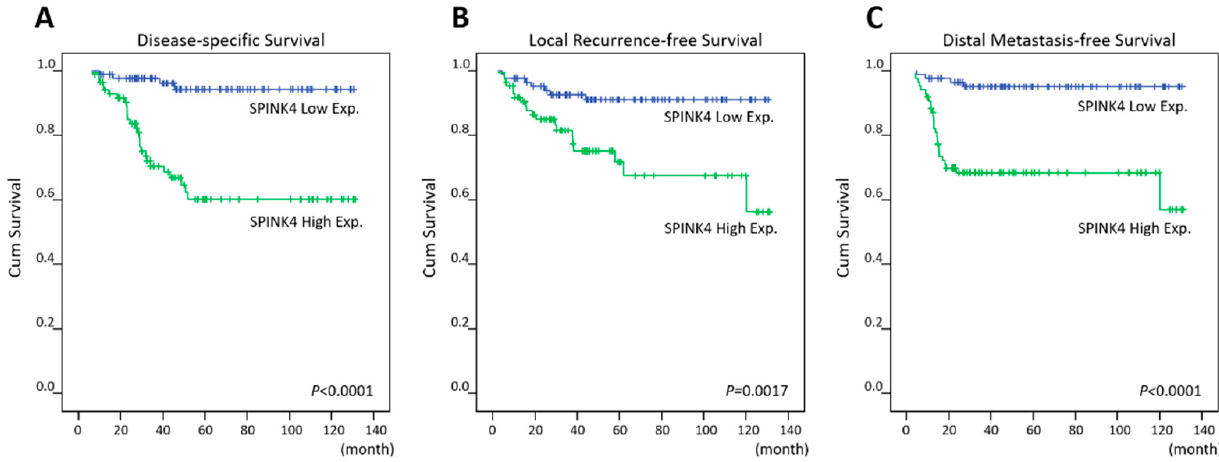
Figure 3. Survival analysis. Kaplan–Meier plots showed that high SPINK4 immunoexpression was significantly linked to worse ( A ) disease-specific survival, ( B ) local recurrence-free survival, and ( C ) metastasis-free survival. Table 3. Univariate log-rank analyses for important clinicopathological variables and SPINK4 expression.